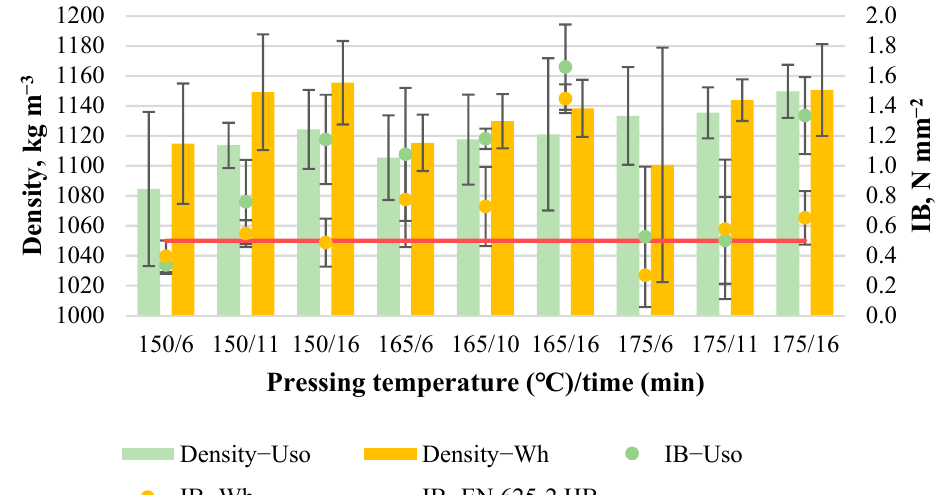
Figure 12. Density and IB of binder-less boards with a density of 1200 kg m − 3 depending on the crop and pressing variables.